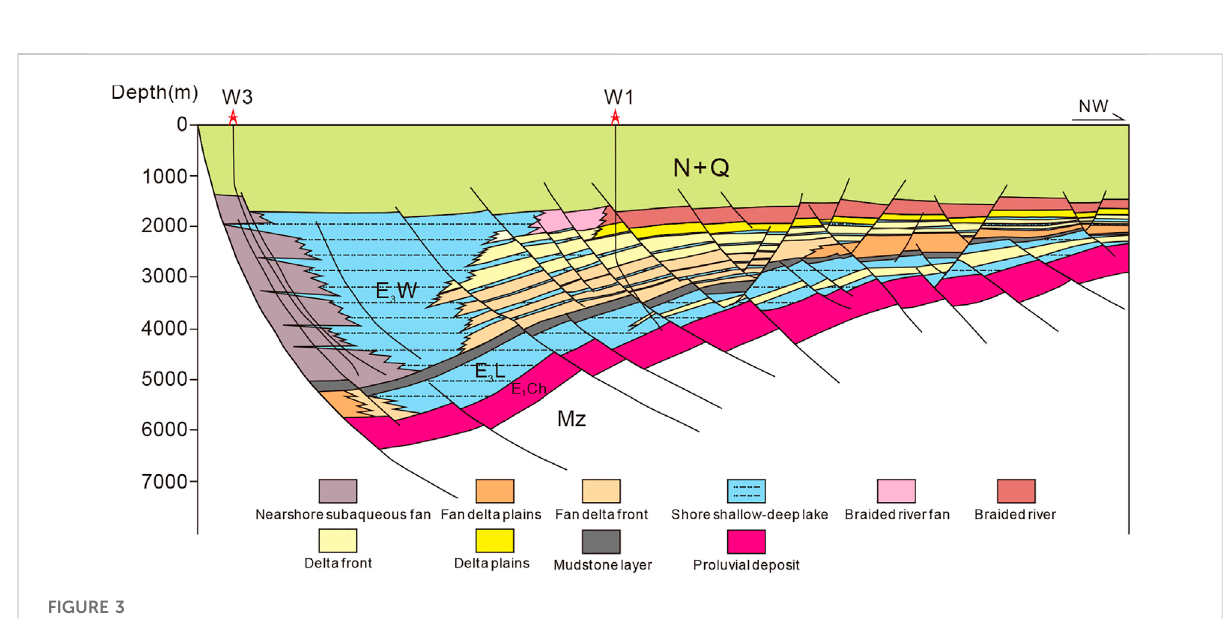
FIGURE 3 Section view and stratigraphy of the research